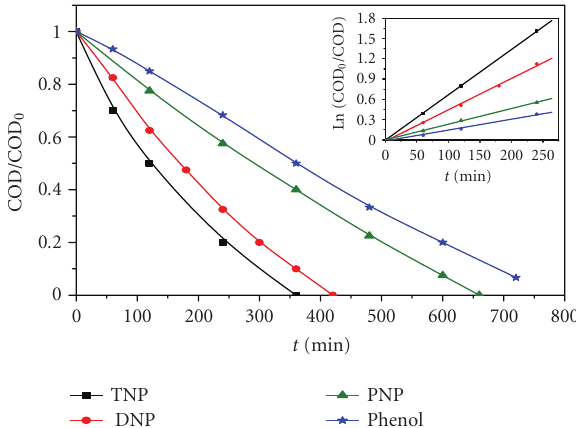
Figure 9: Experiments with pilot plant using solar energy, Kinetics of COD disappearance, in the insert: first-order linear transforms Ln (COD 0 )/COD = f ( t ) of nitrophenols mineralization. Experi- mental conditions: C 0 = 30mg/L, V = 20 L, supported TiO 2 (paper 1048), natural